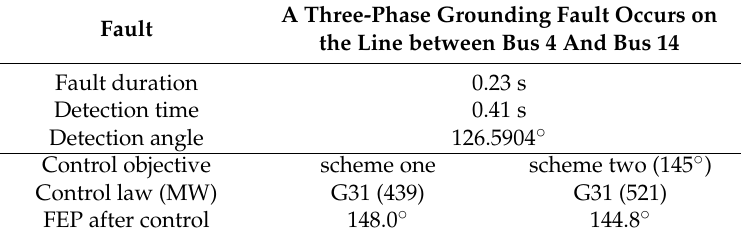
Figure 7. Multi ‐ machine swing curves after fault Table 6. Results of the control system.